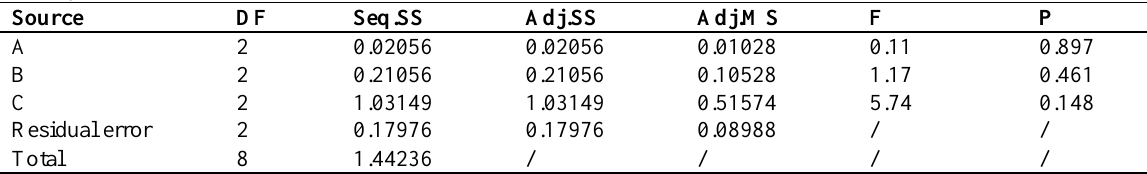
Analysis of Variance for Means (Ra).